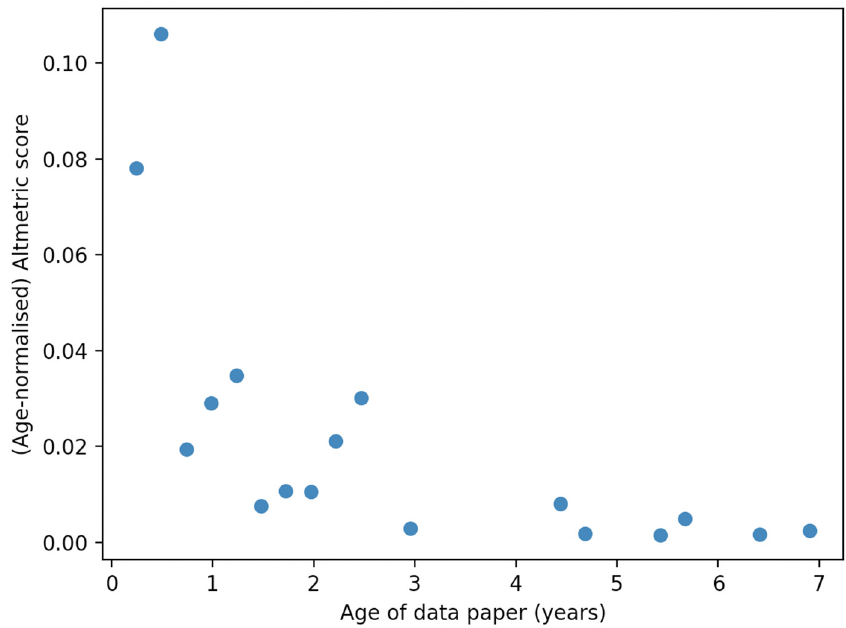
Figure 10. JOHD/RDJ data papers: average Altmetric score over time (3-month ranges).